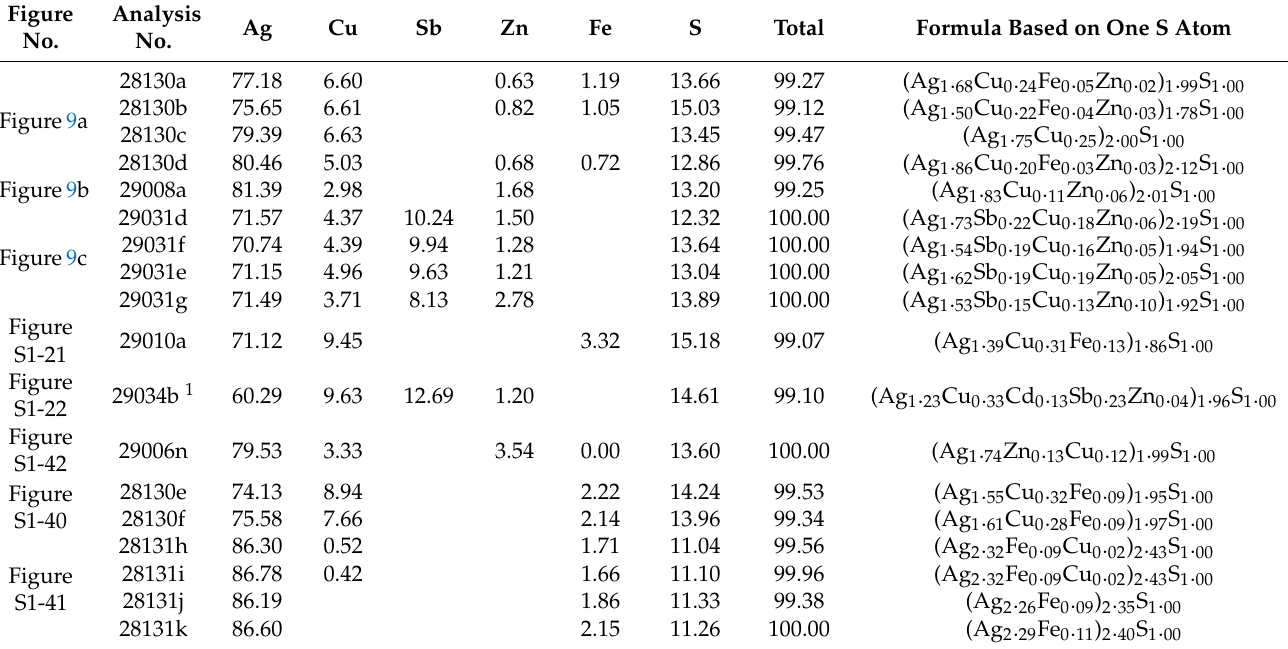
Formula Based on One S Atom